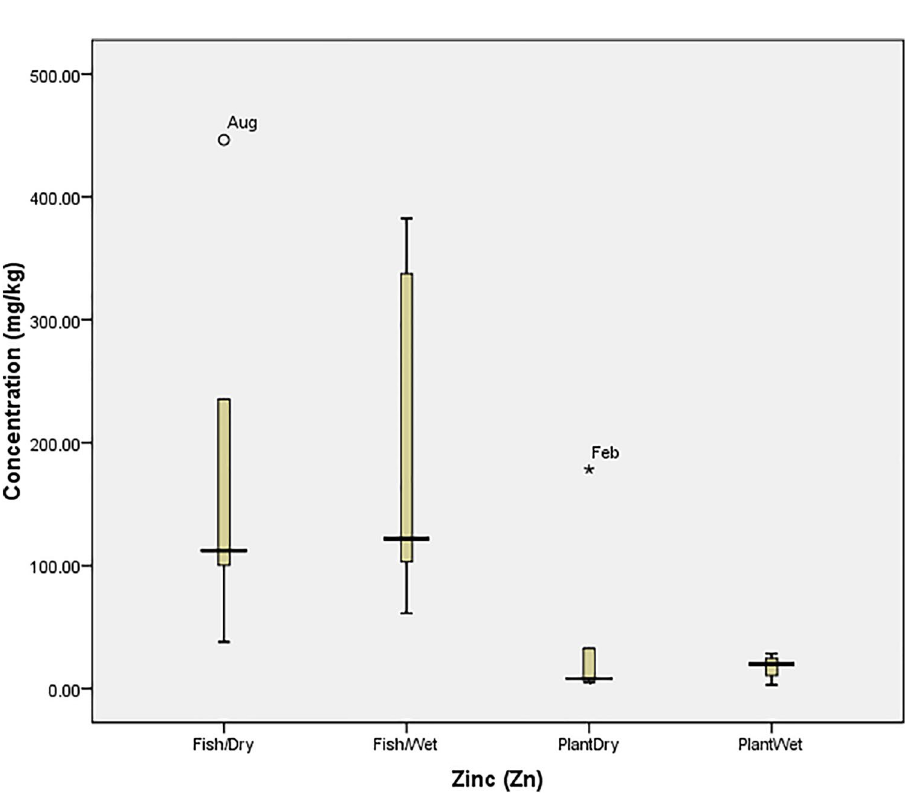
Figure 9. Tolerability of Zinc (Zn) in O. niloticus (Fish) and I. aquatica (Plant) in Wet and Dry Seasons (Source: Field